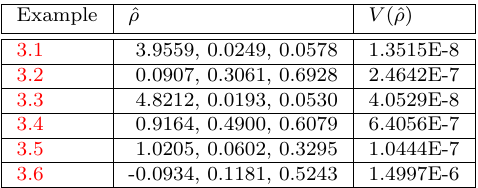
Table 5: Results from Sec. 3.1. Step 2 in Alg. 2.1, i.e. optimal DIPTD model approximation.